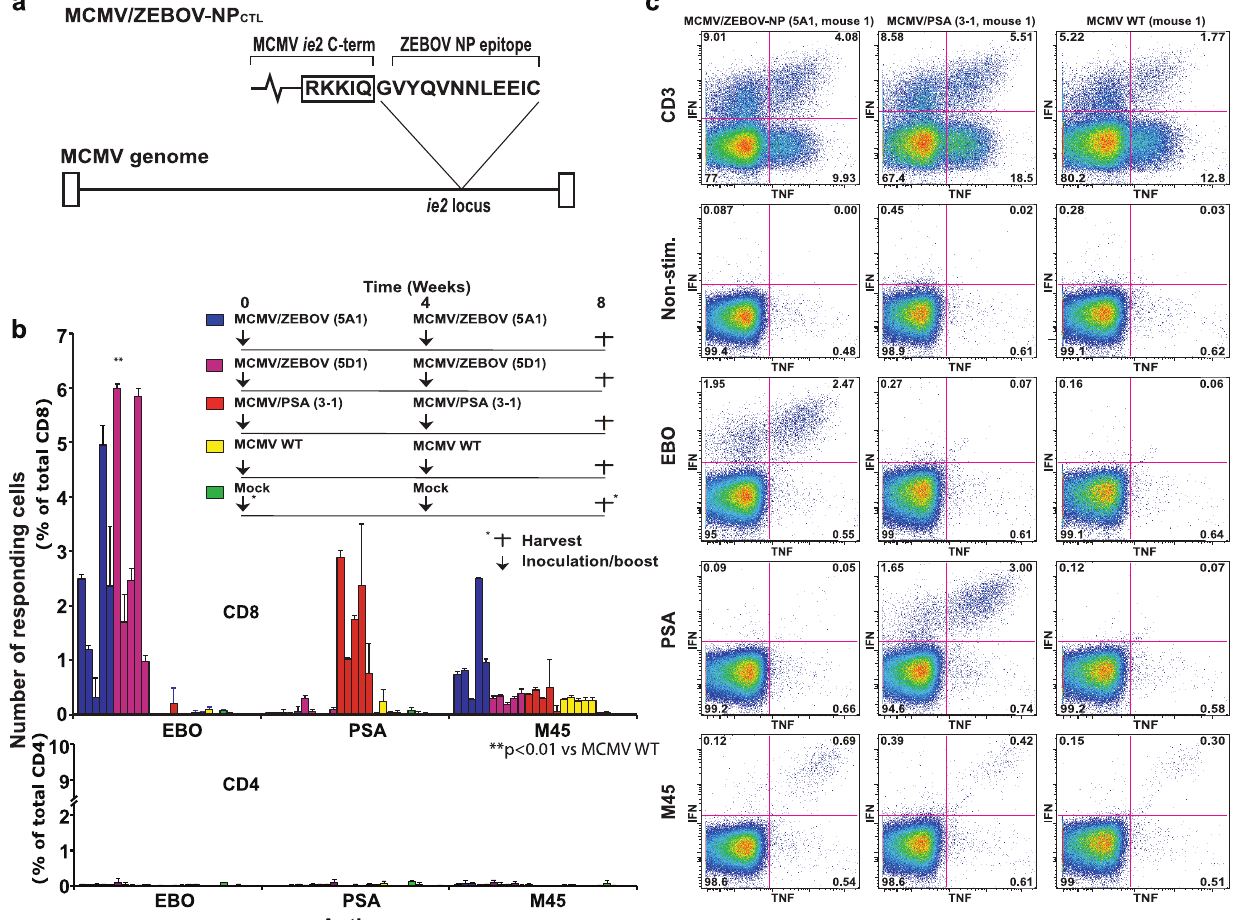
Figure 1. T cell responses following immunization with MCMV/ZEBOV-NP CTL . (a) Schematic representation of MCMV/ZEBOV-NP CTL . An H2 b - restricted T cell epitope from ZEBOV NP (VYQVNNLEEIC) was fused ‘in-frame’ to the carboxyl terminus of MCMV IE2 ( ie2 ) generating the